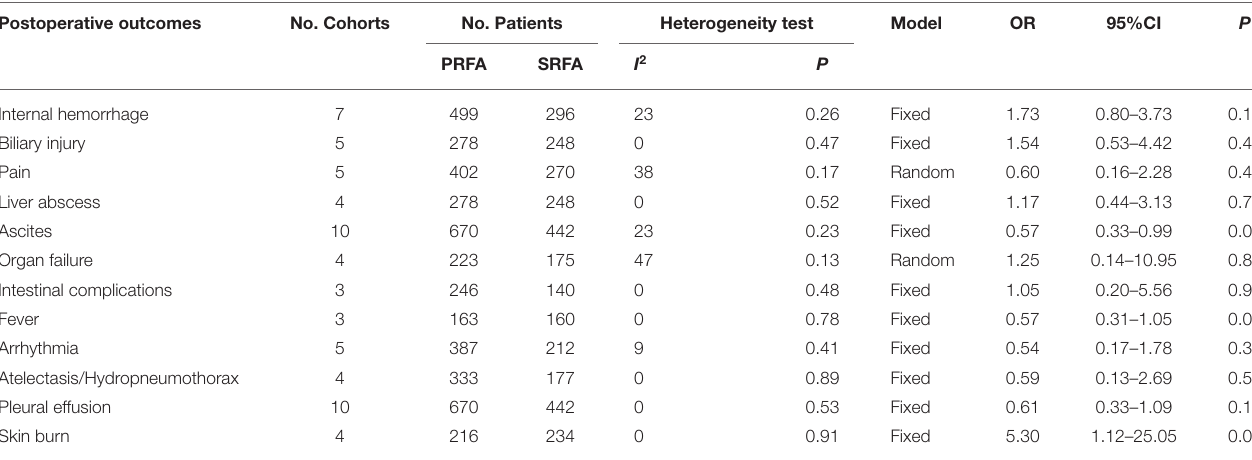
TABLE 3 | Meta-analysis results of all available studies in complication treatment